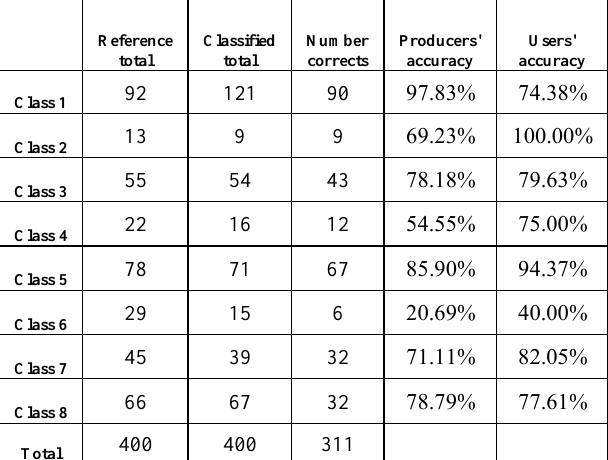
Table 3 : Analysis of reliability and accuracy results from the confusion matrix for the edges-based image classified by ML method.